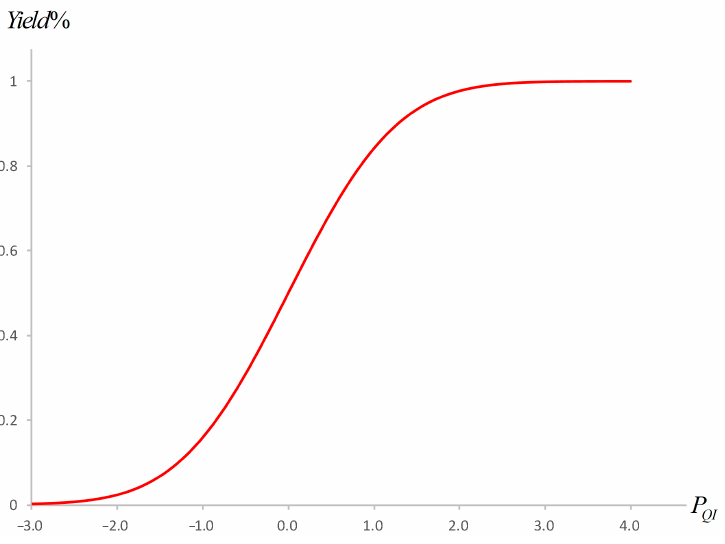
Figure 1. The relation between index P QI and process yield Yield Not only can the process quality index